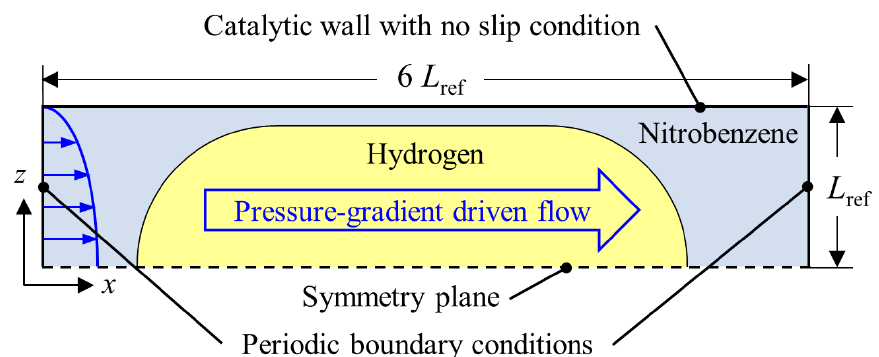
Figure 4. Computational domain and boundary conditions for gas-liquid Taylor flow for hydrogenation of nitrobenzene in a two-dimensional unit cell.